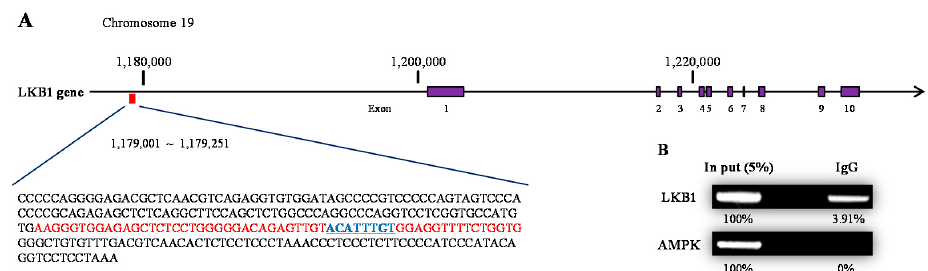
Figure 6. Testosterone cooperating with AR is recruited in the promotor of the LKB1 gene. In SNU-423 cells (human), testosterone (10 nM) was added to the existing media, and the cells were incubated for 2 h. ( A ) The region of AR occupancy on the LKB1 gene is located 26,931 bp upstream of the transcription initiation site (1,205,778 in chromosome 19). Probe sequence and ARE motif were indicated with red and blue, respectively. ( B ) Binding with LKB1 and AMPK gene promoters were detected by antibodies of IgG and AR. The binding intensity was quantified comparing with the ‘5% input’ sample.